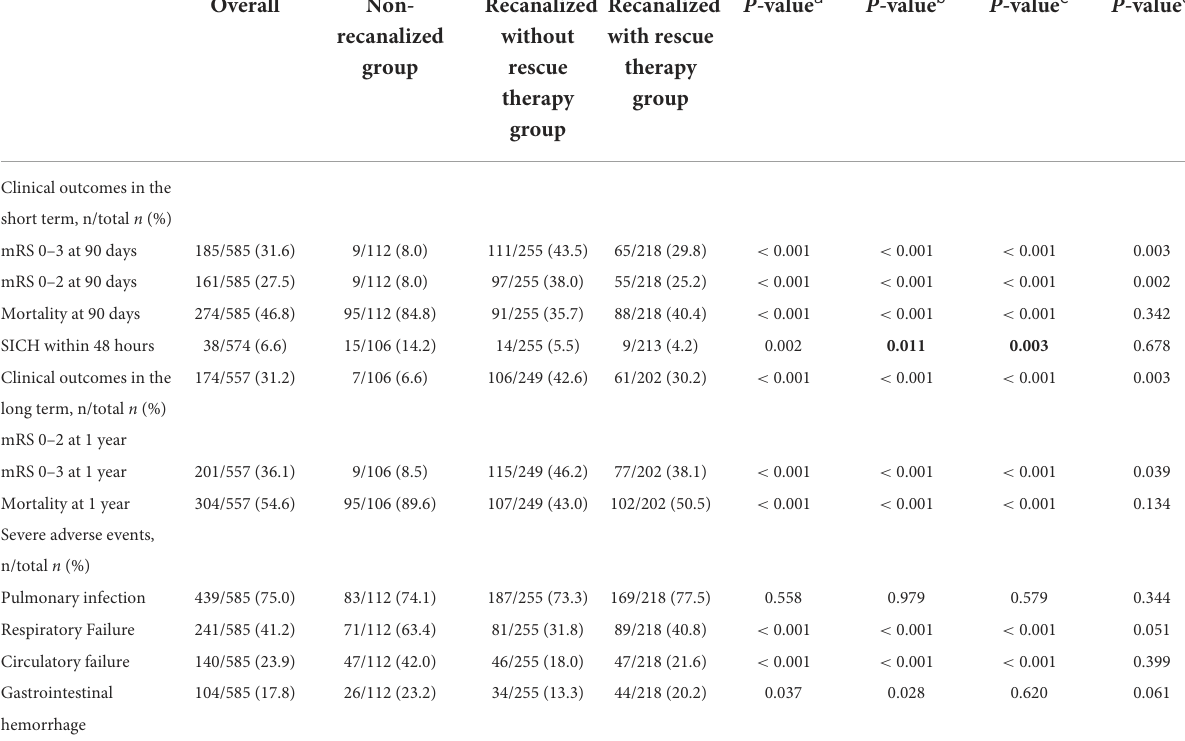
TABLE 2 Comparisons of clinical outcomes among recanalized patients with or without rescue therapy and non-recanalized patients.